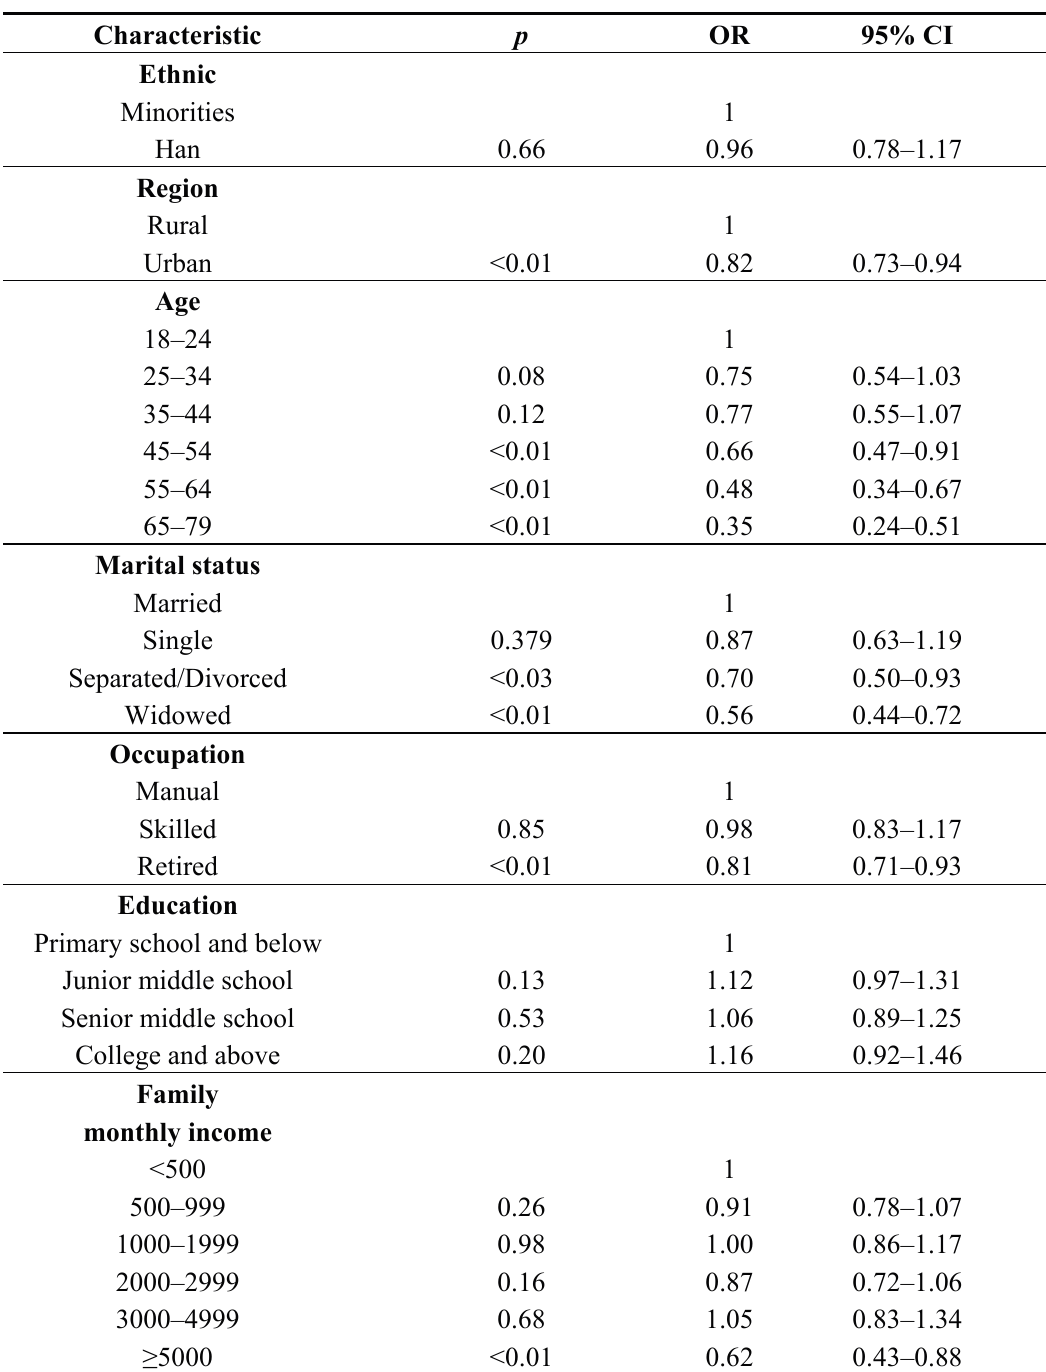
Table 4. Association between socio-demographic factors and passive smoking among non-smoking women aged 18 years or over, Jilin Province,